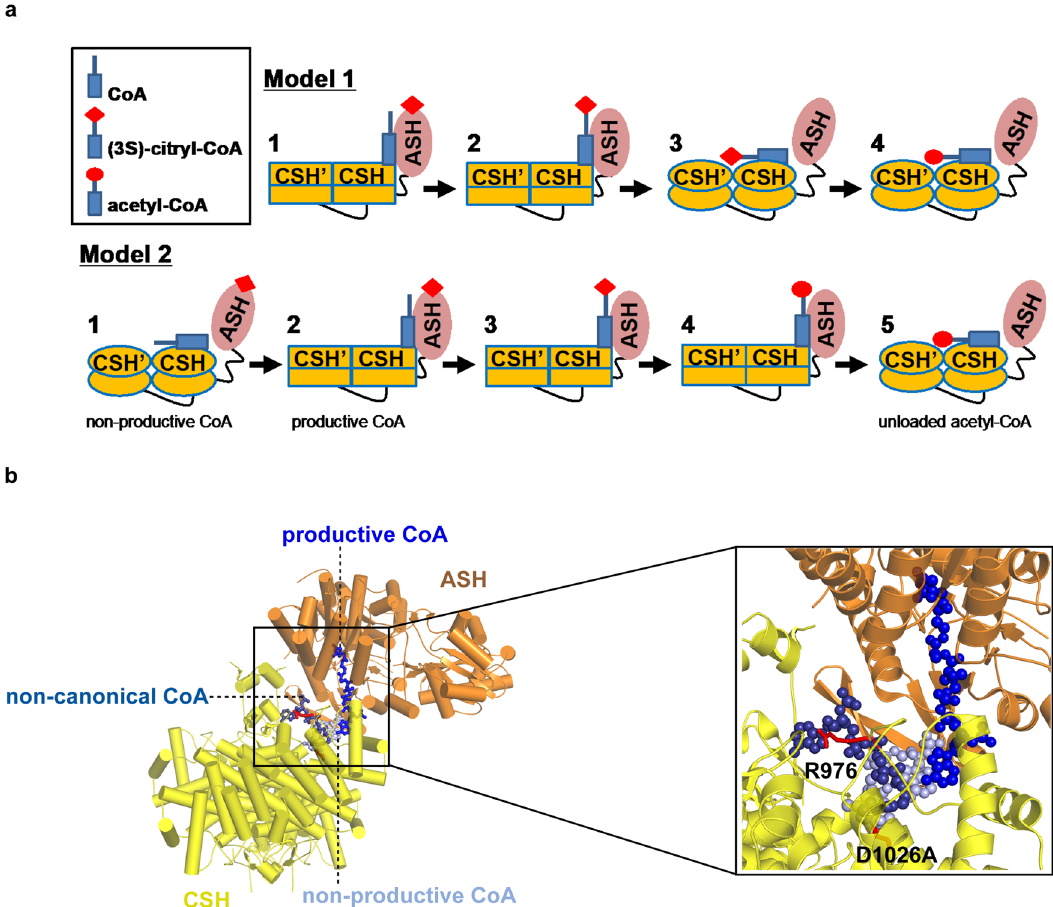
Fig. 1 | Modelsfor ACLYcatalysisandCoAbindingmodes. a Model 1 — ACLY-WT in complex 1 binds CoA through the ASH domain to form (3 S)-citryl-CoA in the ASH domain (complex 2). (3 S)-citryl-CoA then translocates to the CSH domain where catalysis to acetyl-CoA occurs (complex 4). Model 2 — ACLY-WT in